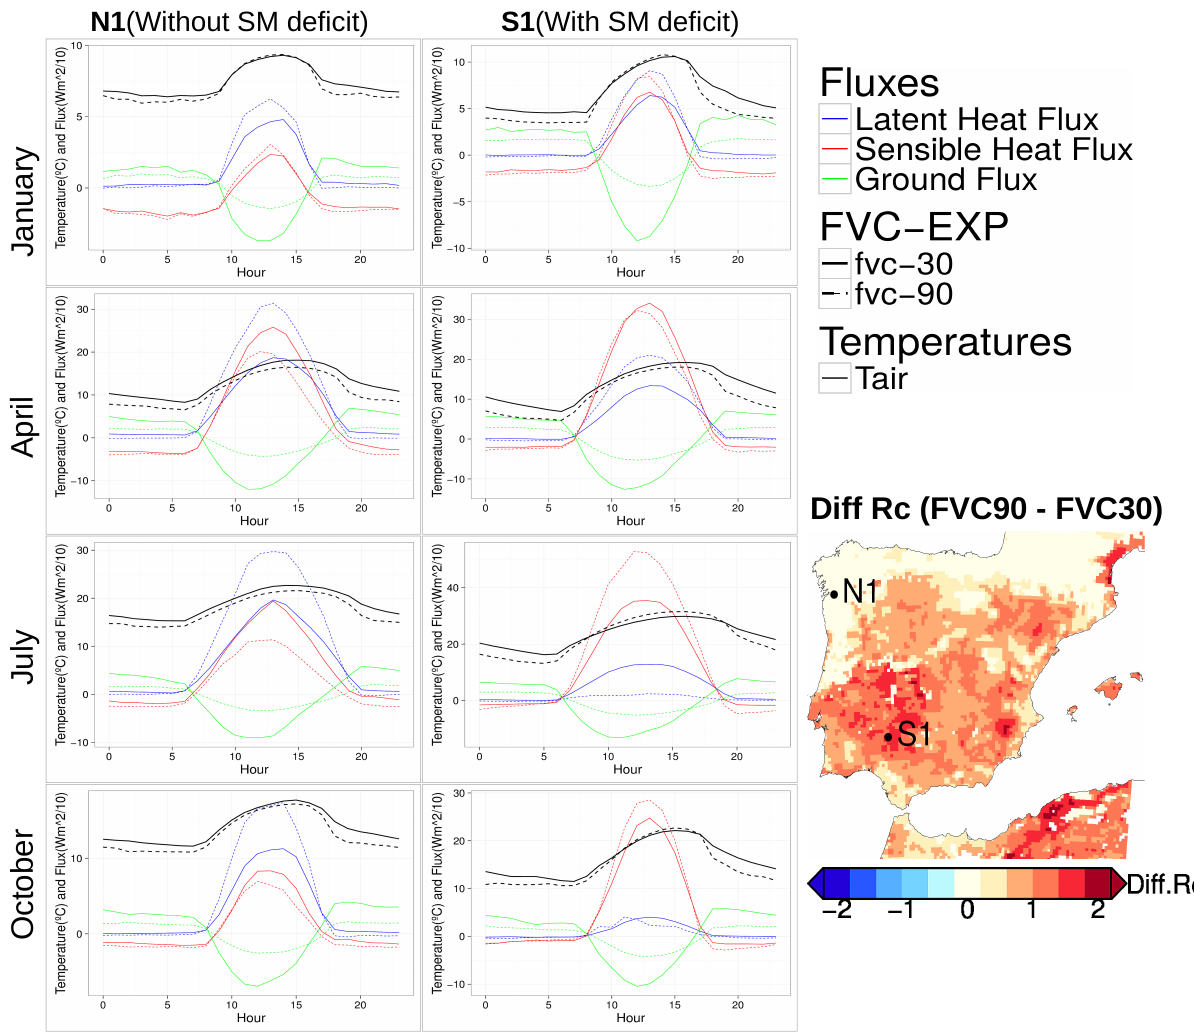
Figure 8. Hourly means averaged for January, April, July and October. T2m (black line), H (red line), LE (blue line) and G (green line) for experiments FVC90 (dashed line) and FVC30 (solid line). Representative locations without SM deficit (N1) and with SM deficit (S1).